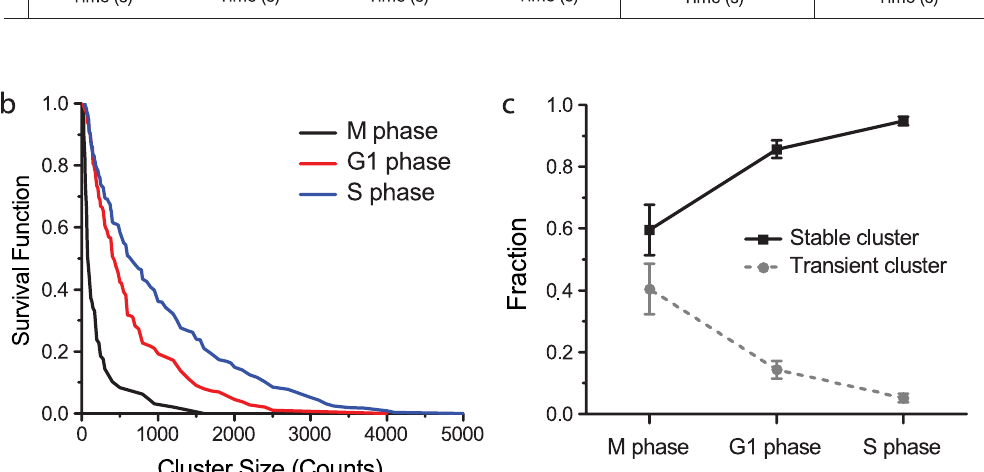
Runx2/SL1 dependent transcription inhibition 54 . The stable clusters in M phase are likely attributable to previ- ously initiated and elongating polymerases that remain bound to the rDNA genes during mitosis. The transient clusters, however, may be due to the absence of the SL1 as we observed in our drug inhibition experiments in Fig. 3. To quantify the differences in Pol I cluster dynamics between different phases of the cell cycle, we evaluated both the portion of transient and of stable clusters and the size distribution of the stable clusters [Fig. 4(b)].